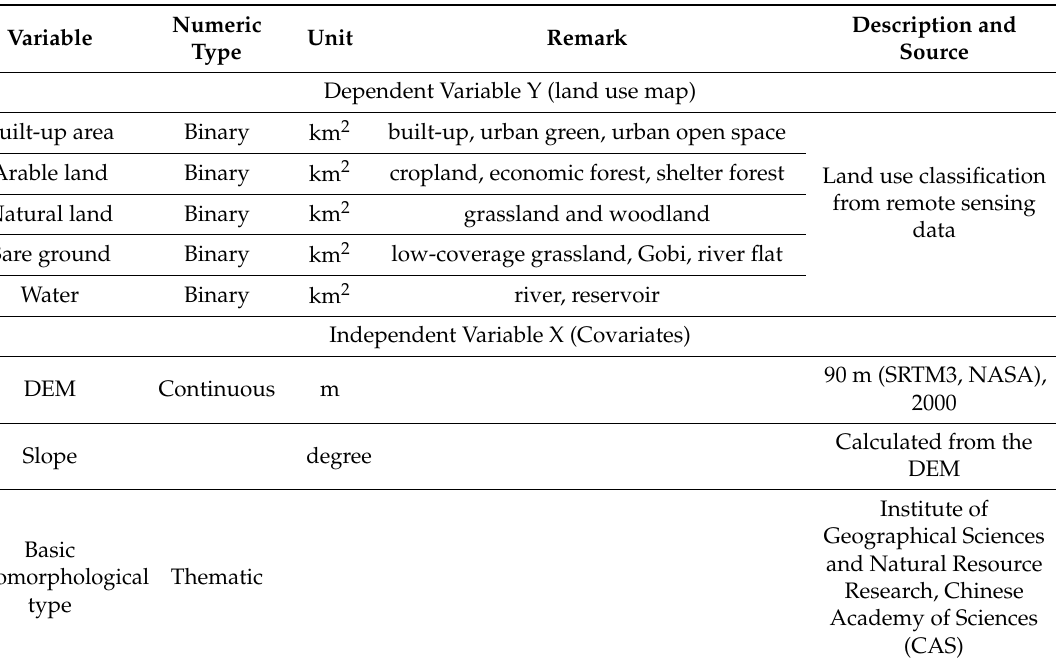
Table 1. Dependent and independent variables used in this